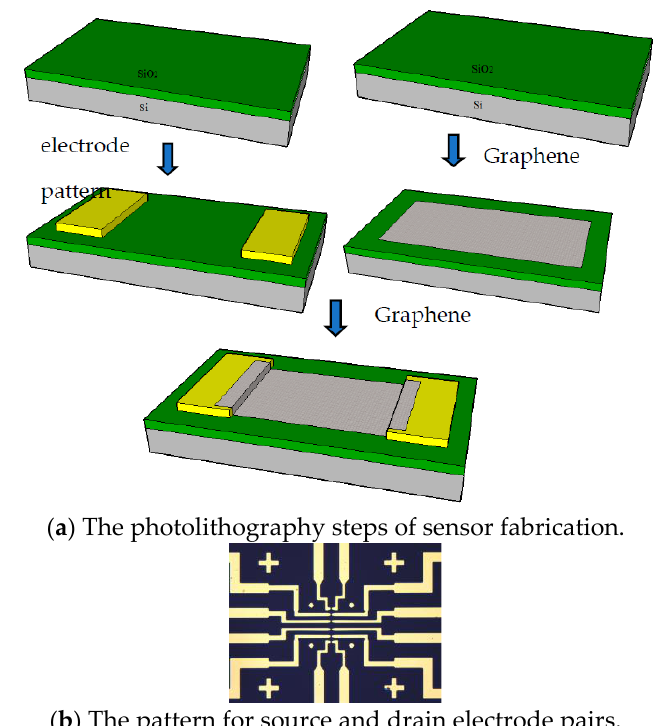
Figure 2. The schematic figures for the fabrication steps of the biosensor. ( a ) The sensor surface material had been processed in two photolithography process. ( b ) The fabrication of gold electrodes was according to the designed pattern.